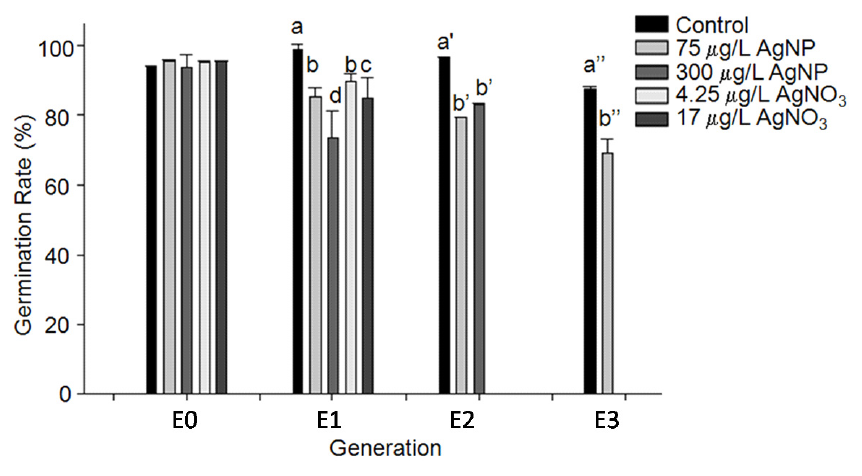
Figure 2. Reproductive nanotoxicity of AgNP and AgNO 3 in Arabidopsis. This showed 20 nm AgNPs affected seed germination; it also showed stronger toxicity of AgNPs than that of AgNO 3 on germination in E1 generation. Different letters indicate significantly